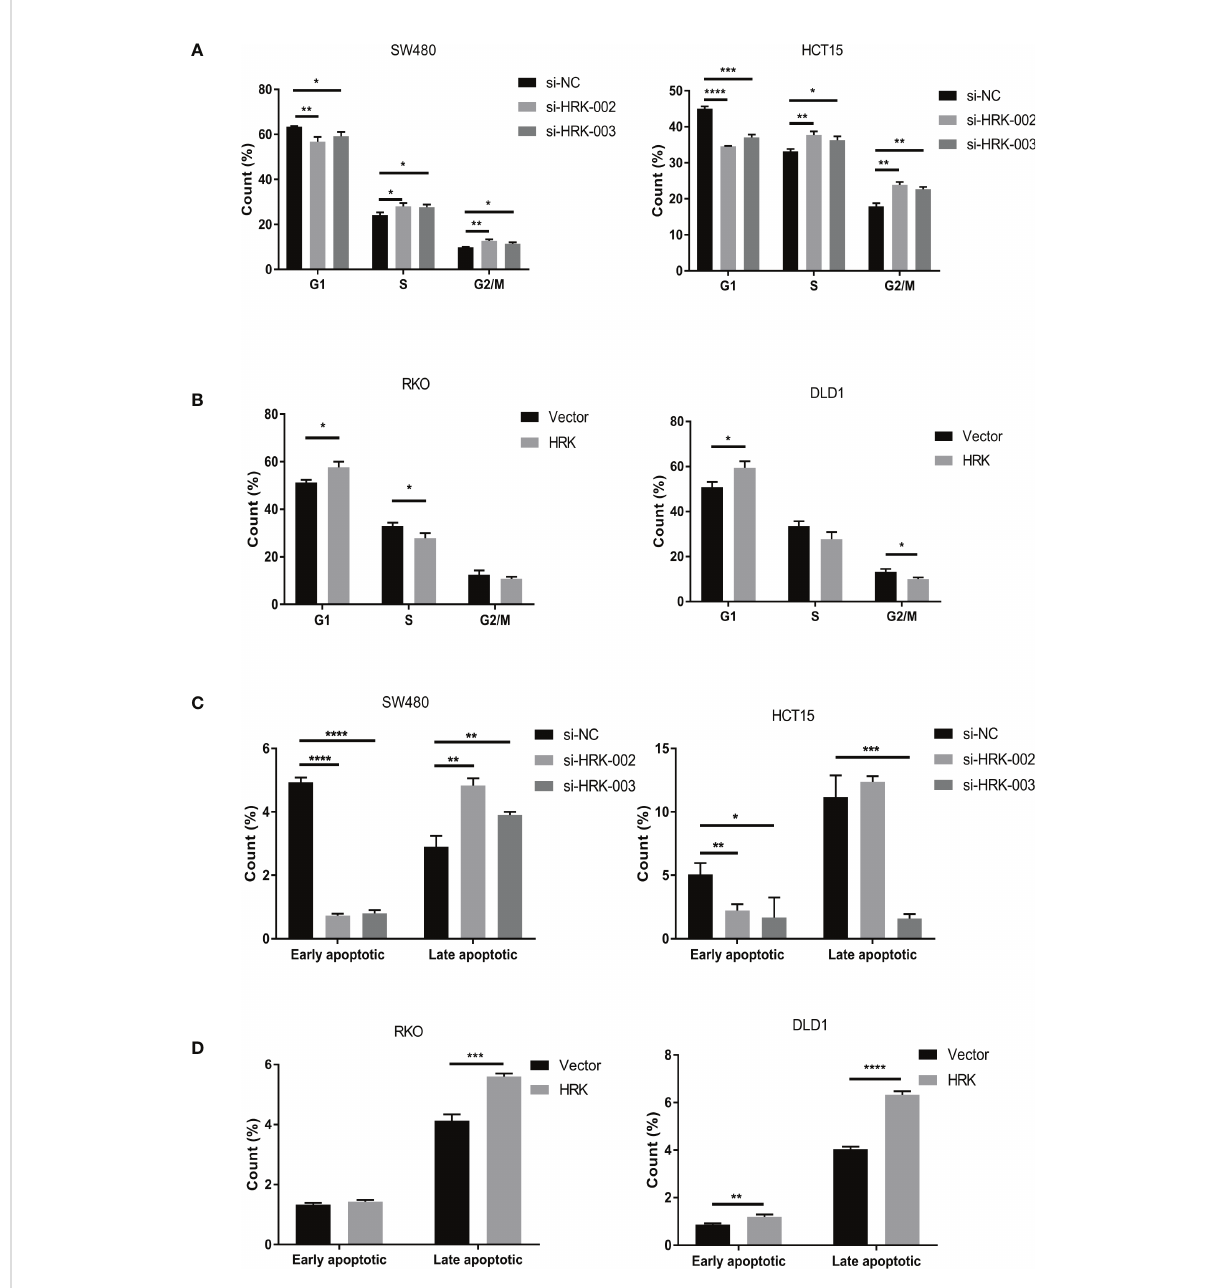
FIGURE 5 HRK regulates CRC Cell cycle and Apoptosis. (A) , The effects of HRK reduction on cell cycle progression by fl ow cytometry. (B) , The effects of HRK overexpression on cell cycle progression by fl ow cytometry. (C) , The effects of HRK reduction on cell apoptosis by fl ow cytometry. (D) , The effects of HRK overexpression on cell apoptosis by fl ow cytometry. Data are expressed as the means ± SD in 3 independent experiments. * P < 0.05, ** P < 0.01, *** P < 0.001 and **** P <